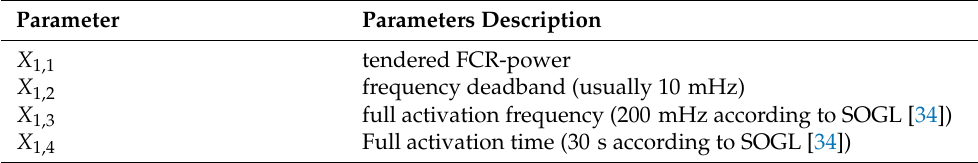
Table 2. Parameters X 1 of function F 1